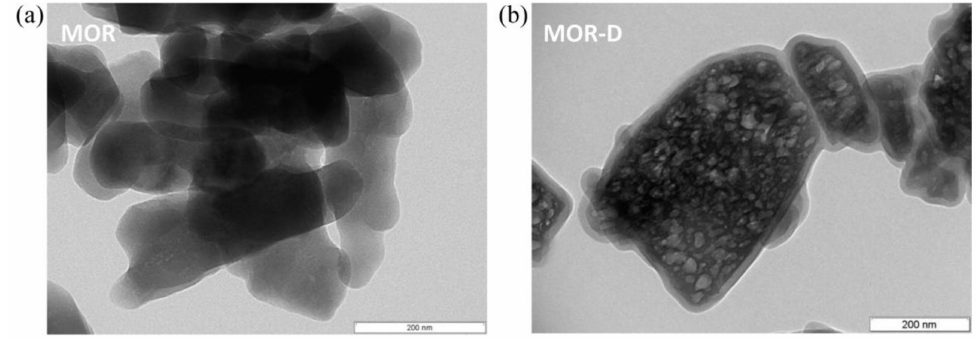
Figure 9. TEM images of ( a ) parent (MOR) and ( b ) desilicated MOR (MOR-D) zeolites. Reproduced with permission from Reference [90]. Copyright (2013) Elsevier